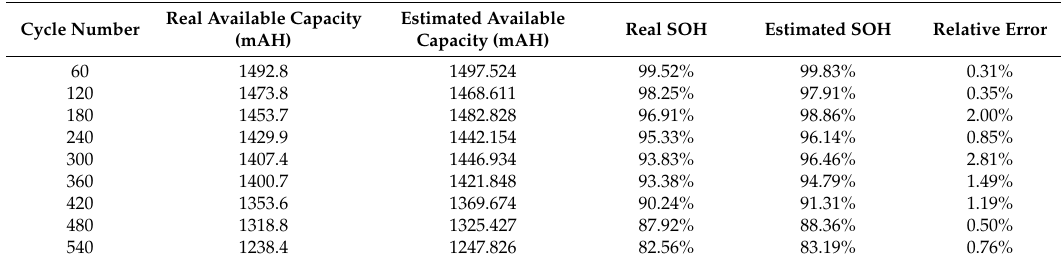
Table 7. Estimated error of No.2 battery in test